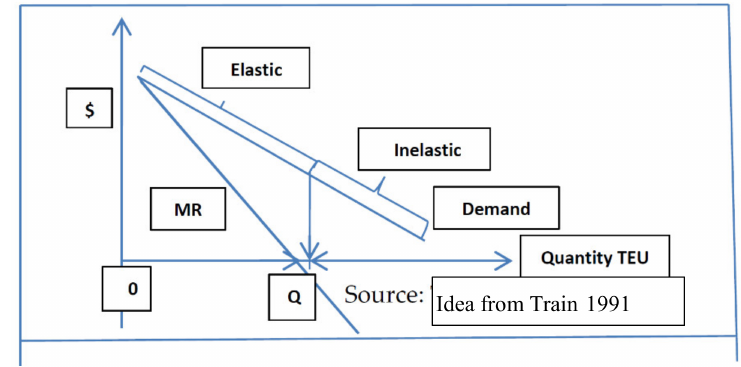
Figure 7. Elasticity of Demand and MR (relationship) at firm’s